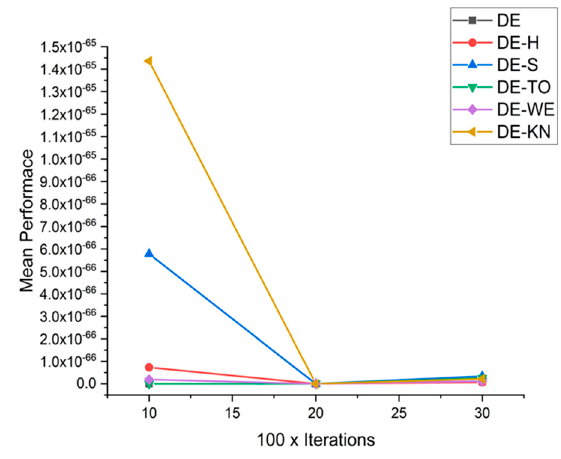
Figure 28. Convergence curve on fn6.